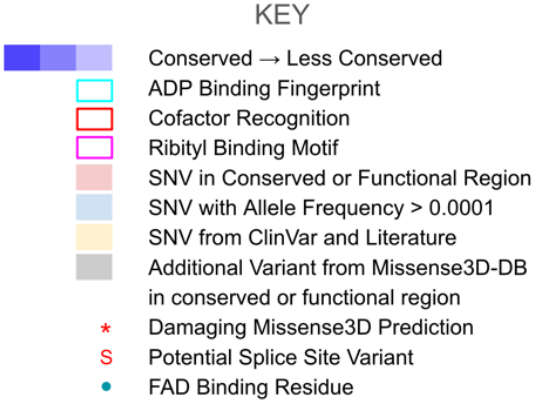
Figure 19. Labeled and annotated multiple sequence alignment of COQ6. Amino acid sequences of COQ6 were analyzed as described in Materials and Methods and include Homo sapiens (NCBI accession number NP_872282.1) and homologs in Saccharomyces cerevisiae (NP_011771.1), Schizosaccharomyces pombe (NP_595401.2) , Escherichia coli UbiH (NP_417383.1) , Escherichia coli UbiF (NP_415195.1) , Caenorhabditis elegans (NP_505415.2), Drosophila melanogaster (NP_608934.1), Danio rerio (NP_001038869.1), Mus musculus (NP_766170.2), and Bos taurus (NP_001039558.1). See KEY for descriptions of the figure annotations. The ADP Binding Fingerprint is boxed in cyan, the Cofactor Recognition motif is boxed in red, and the Ribityl Binding motif is boxed in magenta, data from [89]. FAD-binding residues are marked with blue dots, data from [49].